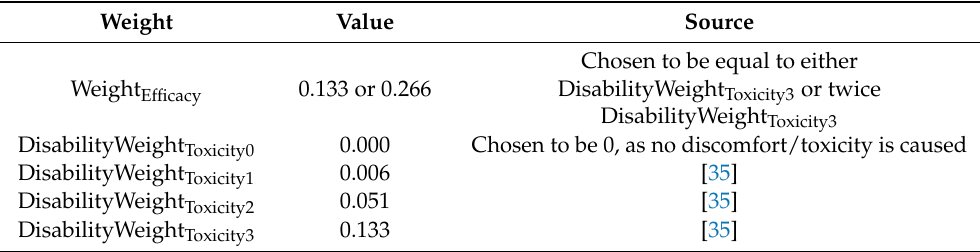
Table 2. Disability and efficacy weights for the utility functions. Weight Value Source Weight Efficacy 0.133 or 0.266